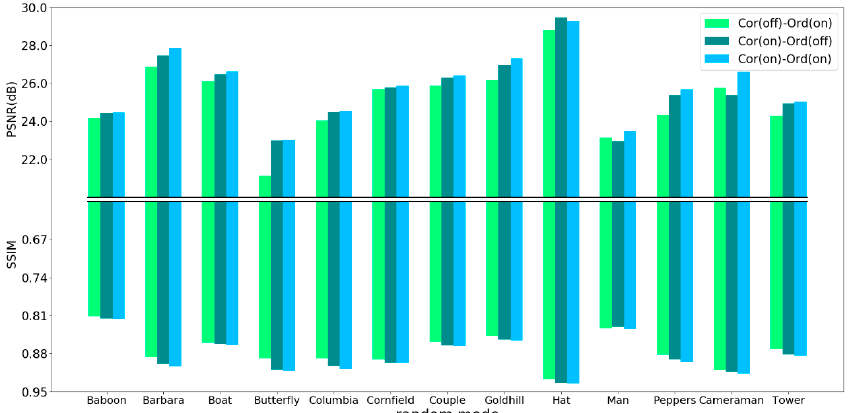
Figure 14. The influence of the proposed correction and adaptive scan order to the final EC performance under the 16 × 16 regular consecutive loss mode.